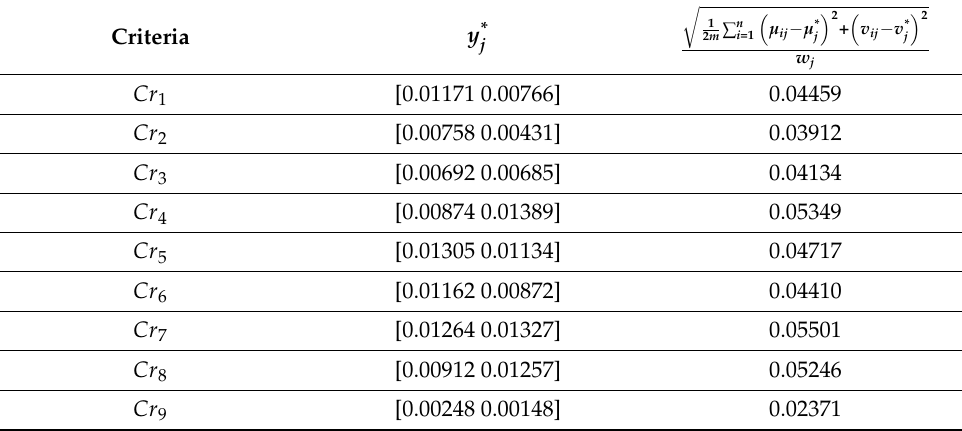
Table 9. Amounts of ideal point method